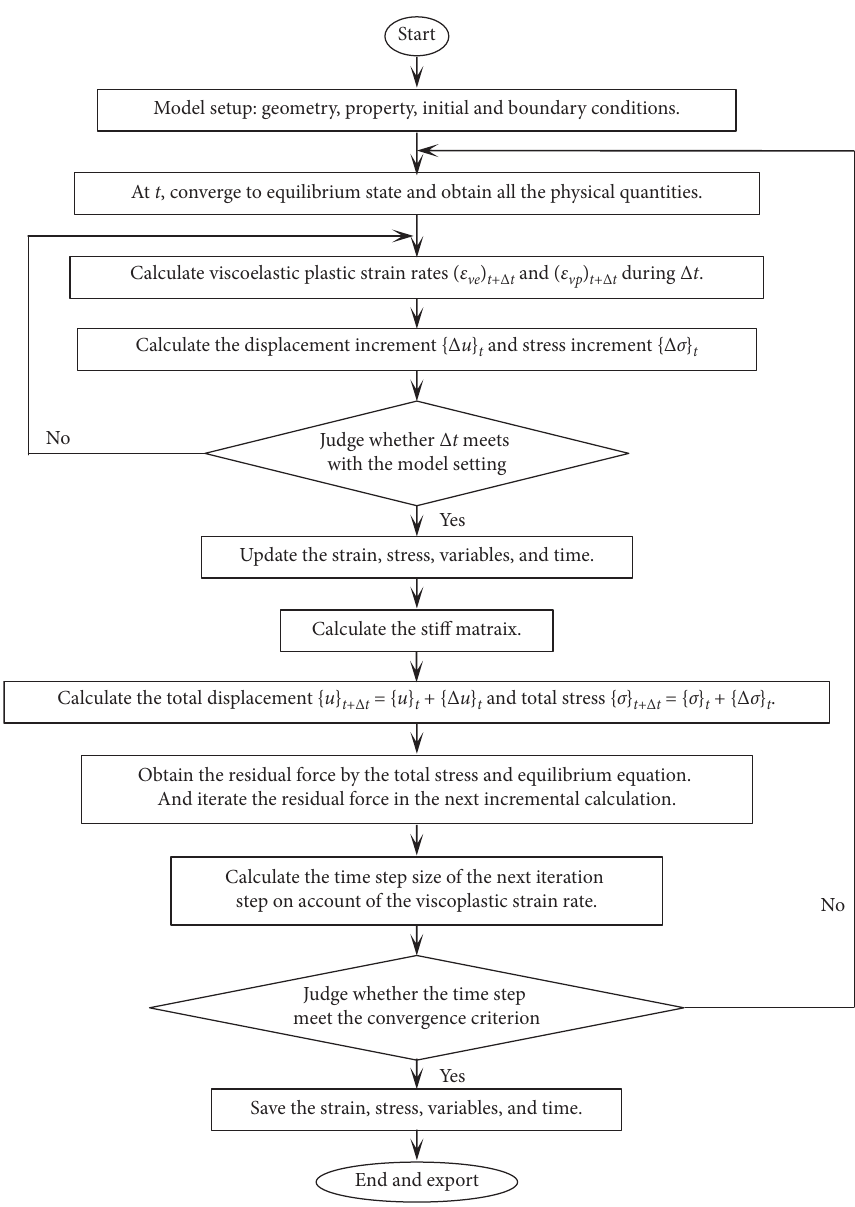
Figure 2: Programming